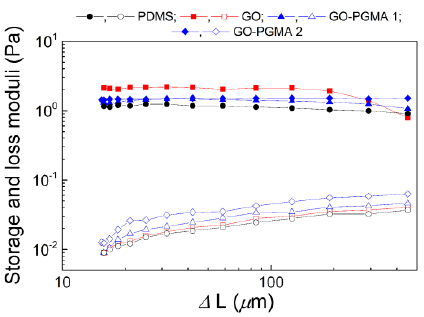
Figure 9. Dependence of the storage (solid symbols) and loss (open symbols) moduli on the change in deformation upon dynamic tensile testing at 1 Hz and 25 °C.